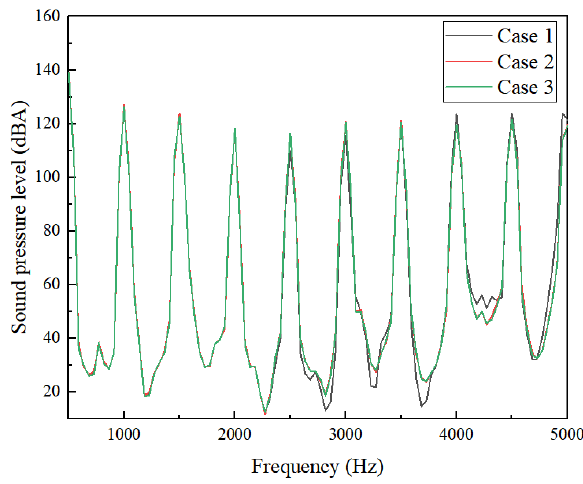
Figure 13. Grid independence verification of the CFD–BEM coupling model.